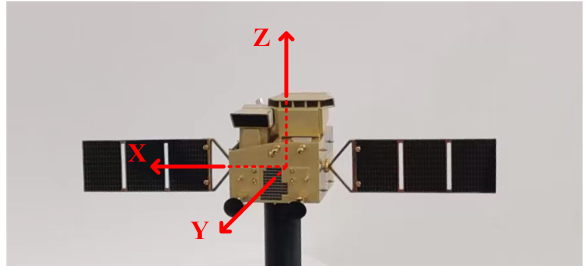
Figure 3. Local coordinate system of the space target